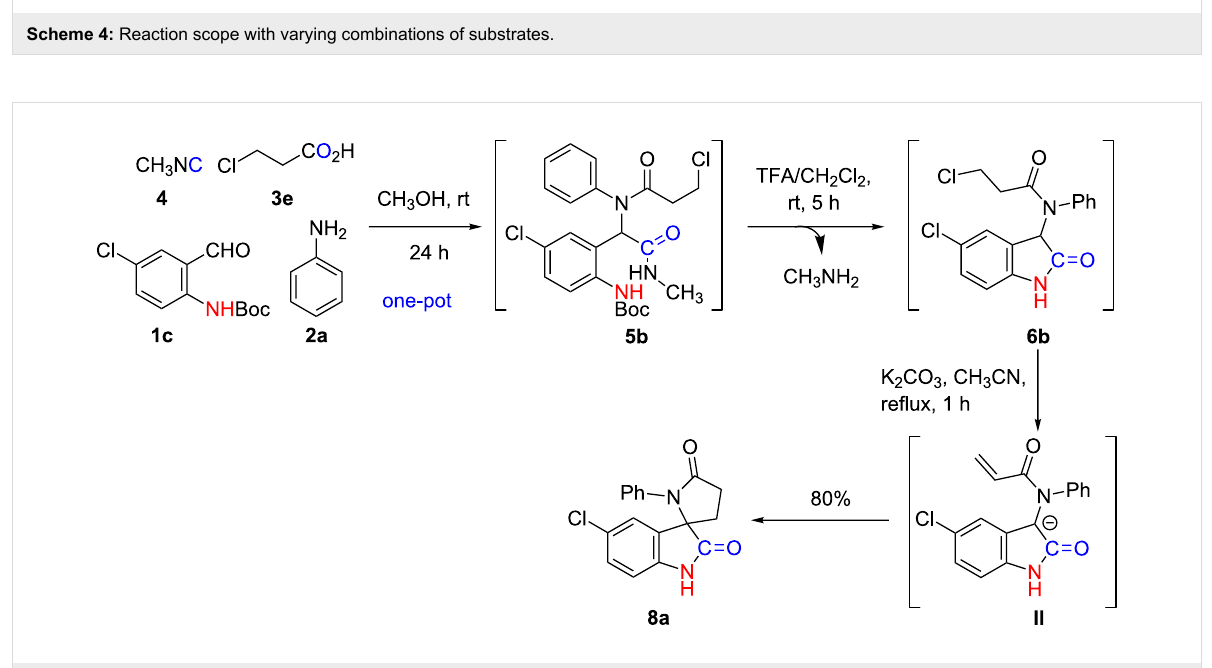
Scheme 4: Reaction scope with varying combinations of